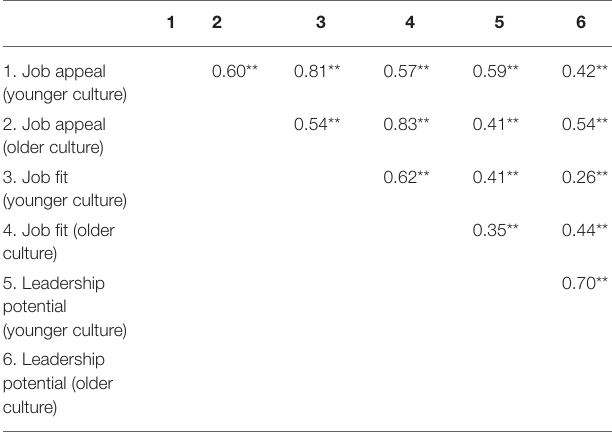
TABLE 8 | Study 3: correlation matrix for all dependent